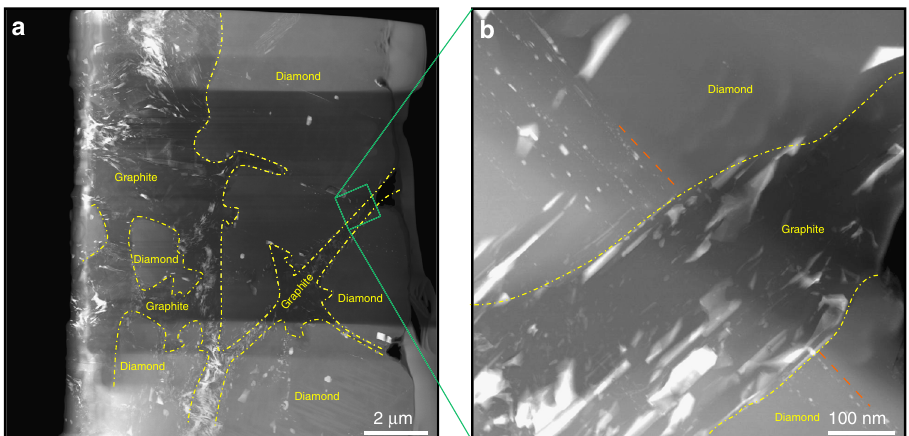
Fig. 2 Inclusion trails imaged inside diamond fragments. a HAADF-STEM image from diamond segments with similar crystallographic orientation. Dashed yellow lines show the diamond – graphite boundaries. b High-magni fi cation image corresponding to the green square in a . Diamond and inclusion trails are cut by a graphite band. The dashed orange line shows the direction of the